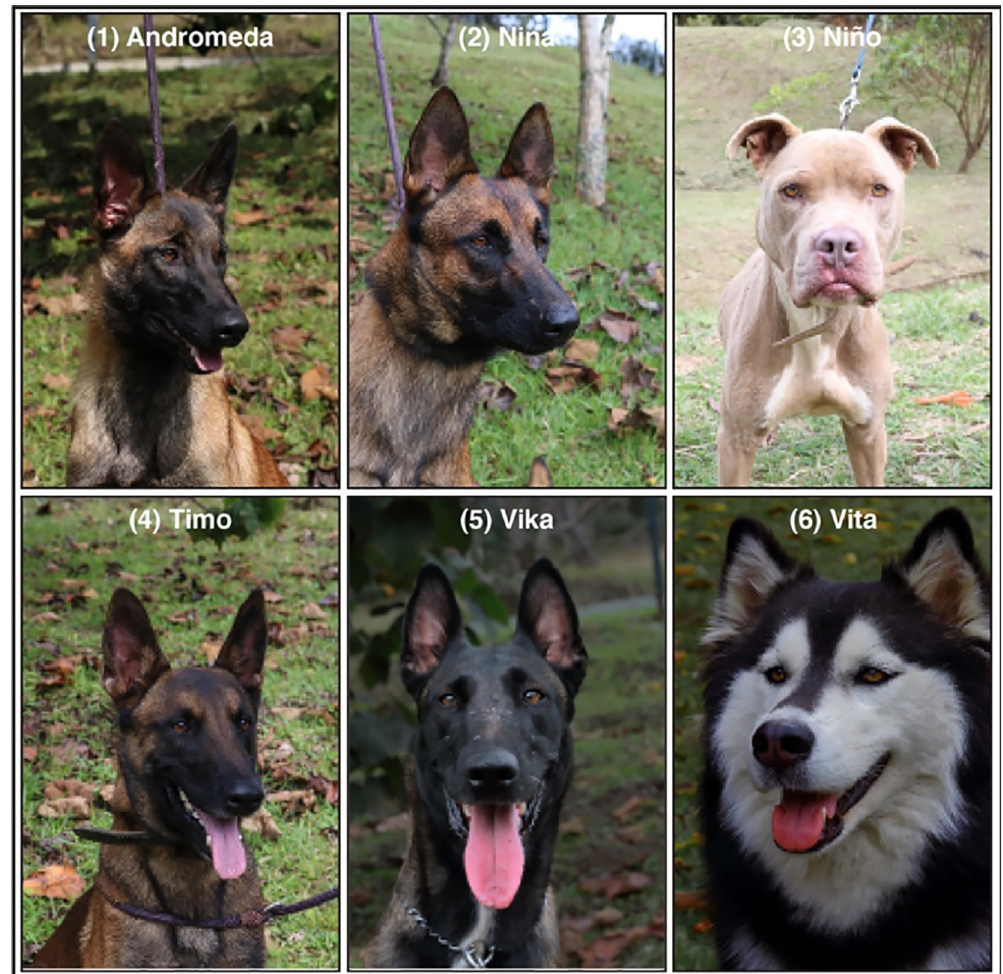
Fig 2. Pictures and identification of the six dogs trained for the scent-detection of SARS-CoV-2. (1) Andromeda, intact female, 6-mo, Belgian Malinois (BM). (2) Nina, intact female, 25-mo, BM, (3) Ni ñ o, castrated male, unknown age, American Pit Bull Terrier. (4) Timo, intact male, 31-mo, BM. (5) Vika, intact female, 36-mo, BM. (6) Vita, intact female, 36-mo, first generation Alaskan Malamute x Siberian